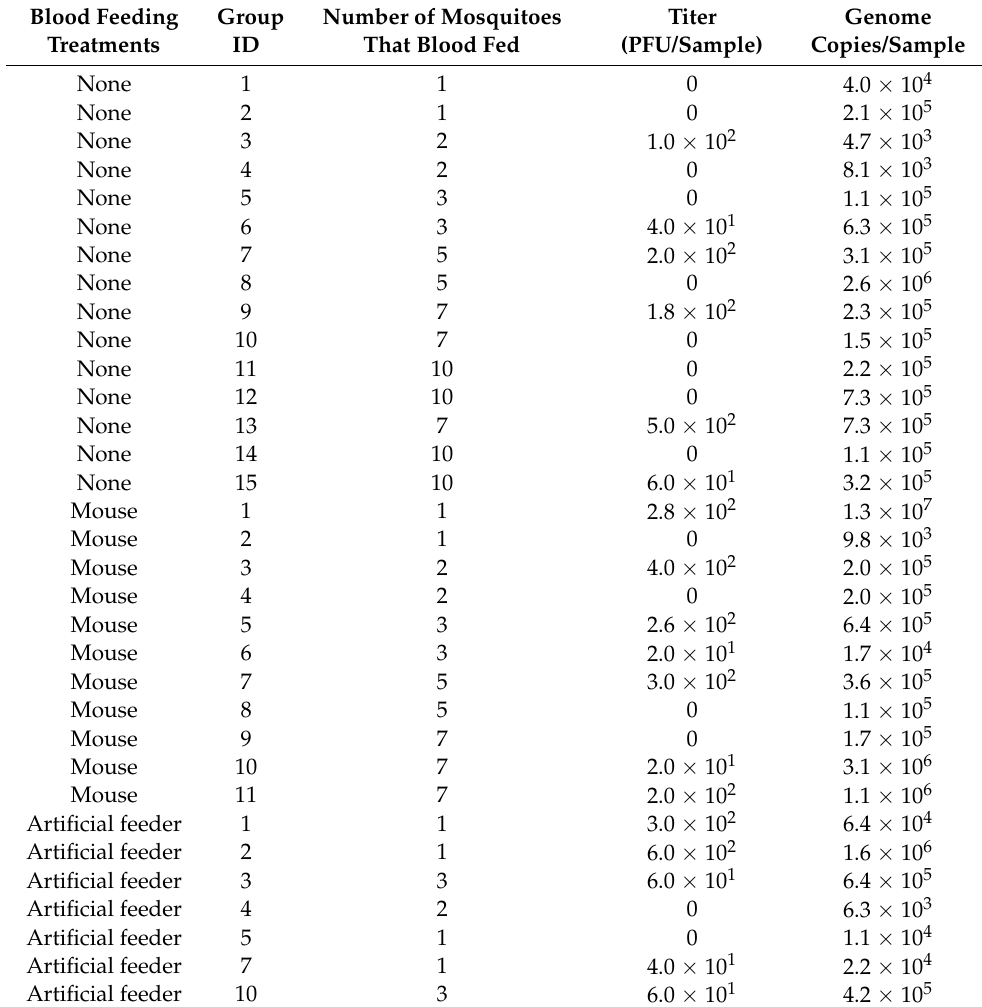
Table 2. Detection of ZIKV from forced salivation samples of groups of infected mosquitoes that underwent different blood feeding